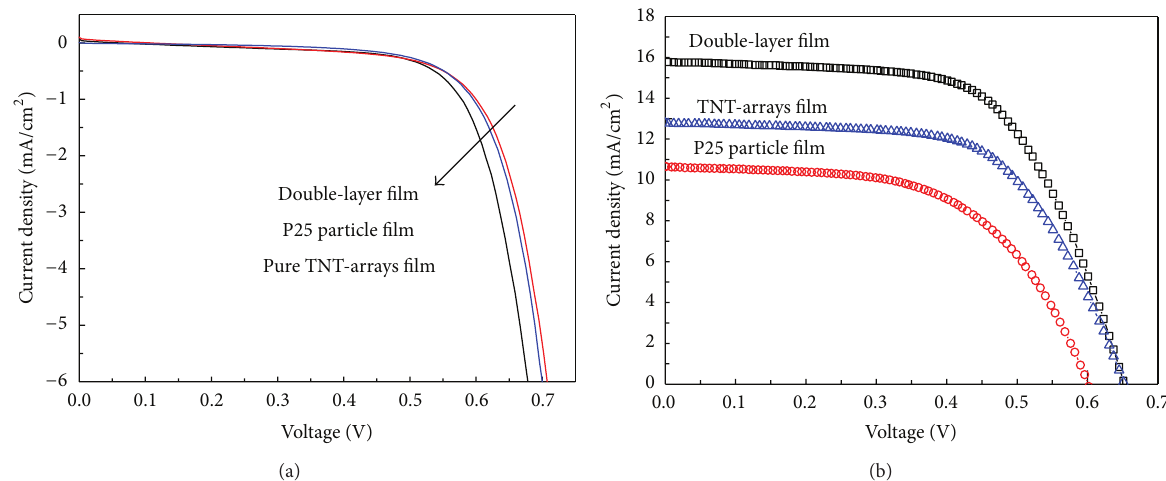
Figure 6: 𝐼 - 𝑉 performance of the DSSCs based on P25 nanoparticle film, TNT-arrays films, and double-layer composite film in the dark (a) and under AM 1.5 illuminations (b).